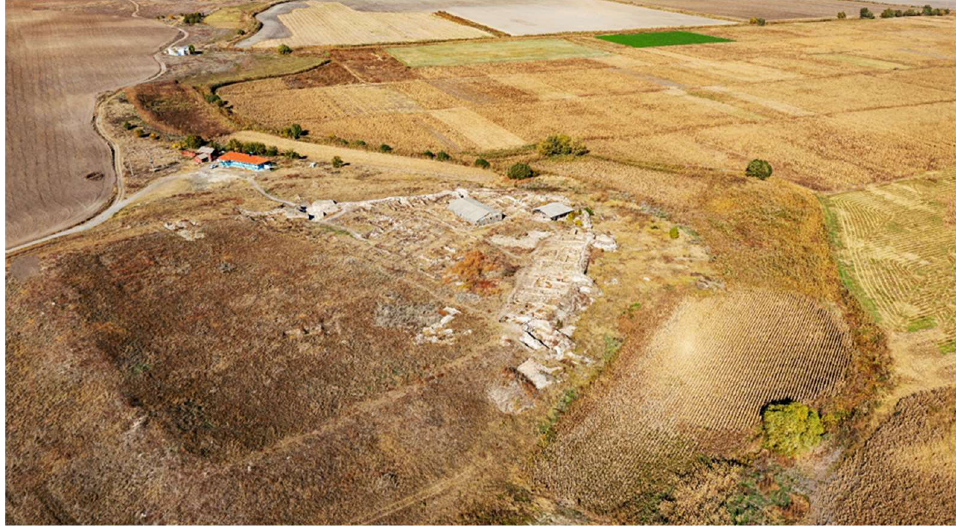
Figure 2. Drone view, from southeast, of Halmyris site (by Valentin Ștefan, October 2022).